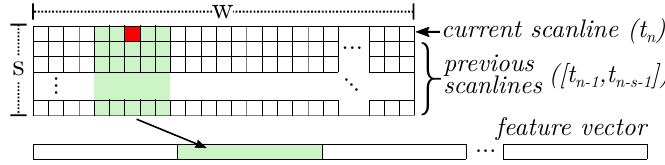
Figure 5. Representation of the feature vector extraction process to classify one pixel (marked in red in the figure). From the t neural codes (NC) obtained for a class (using the current t n and the previous [ t ] scanlines), the s × 5 neighbors to the pixel to be classified are copied to the feature n − 1 , t n − s − 1